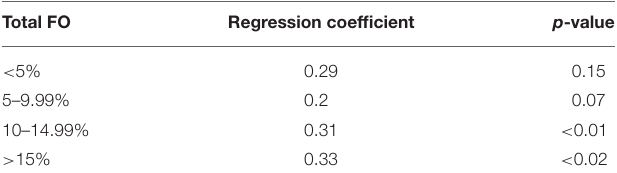
TABLE 3 | Dose response relationship between fluid overload and oxygenation index. Total FO